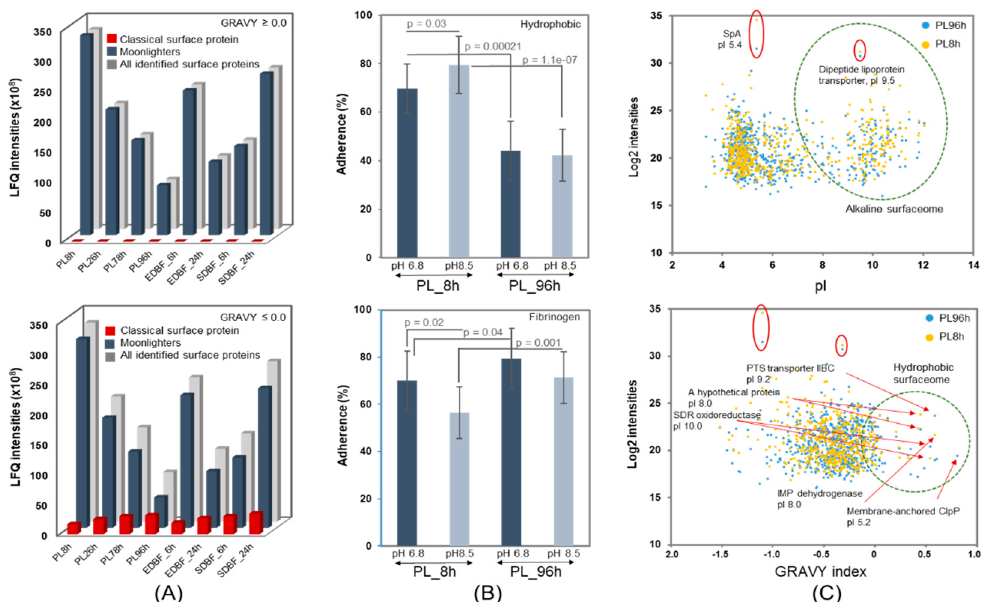
Figure 5. ( A ) Distribution of total LFQ intensities of all identified, moonlighters, and classically secreted proteins in indicated samples with Grand average of hydropathy (GRAVY) values ≥ 0.0 (upper panel) and ≤ 0.0 (lower panel). ( B ) Relative adherence of PL8 h and PL96 h cells to a hydrophobic material (upper panel). Bars in dark and light blue are cells washed with a pH 6.8 ( n = 16) and pH 8.5 ( n = 16) bu ff er, respectively. Relative adherence of PL8 h and PL96 h cells to human fibrinogen (lower panel). Bars in dark and light blue are cells washed with a pH 6.8 ( n = 16) and pH 8.5 ( n = 14) bu ff er. A paired t -test was used to compare the samples. ( C ) Proteins identified from PL8 h and PL96 h cells separated by their LFQ intensity (log2) and pI (upper panel) or GRAVY (lower panel) values. Alkaline and hydrophobic surfaceomes are circled. The most abundant proteins are circled, and highly hydrophobic proteins are marked with arrows.